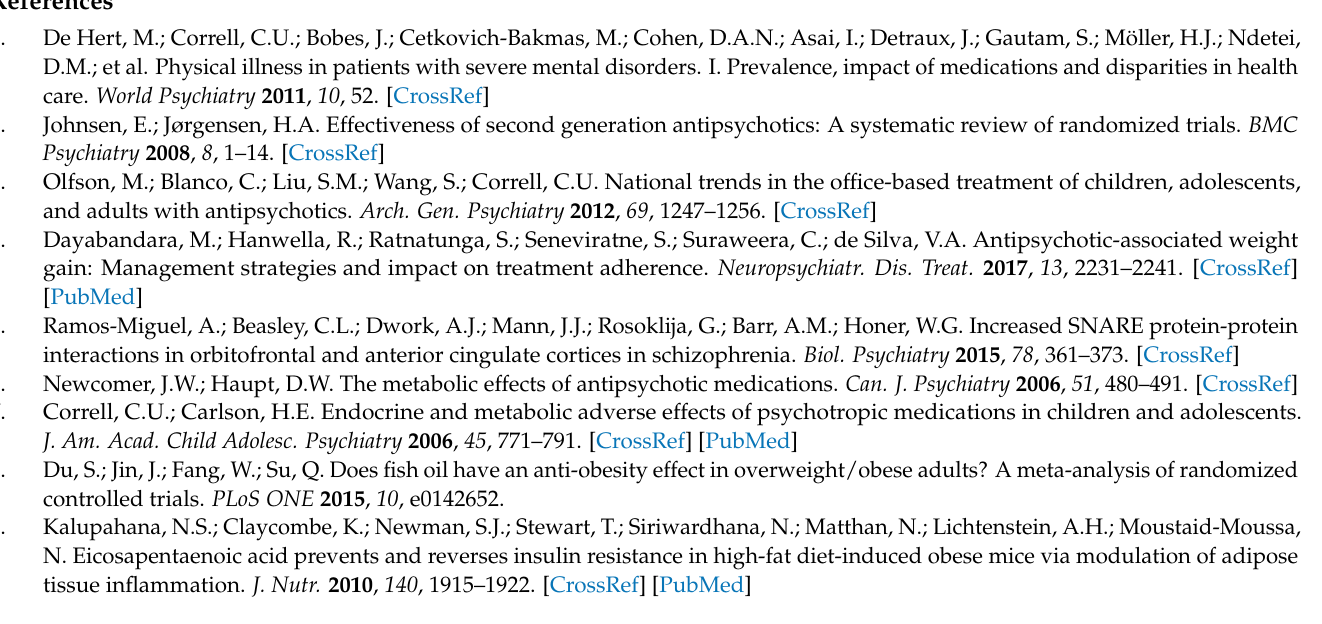
abundance of class level; Figure S4. Pie chart of percent mean relative abundance of order level; Figure S5. Pie chart of percent mean relative abundance of family level; Figure S6. Pie chart of percent mean relative abundance of genus level; Table S1. Diet composition; Table S2. Phylum level relative abundance for male mice; Table S3. Class level relative abundance for male mice; Table S4. Order level relative abundance for male mice; Table S5. Family level relative abundance for male mice; Table S6. Genus level relative abundance for male mice; Table S7. Phylum level relative abundance for female mice; Table S8. Class level relative abundance for female mice; Table S9. Order level relative abundance for female mice; Table S10. Family level relative abundance for female mice; Table S11. Genus level relative abundance for female